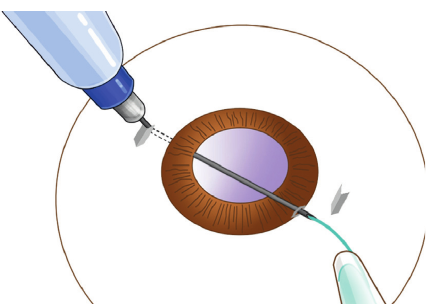
Figure 2: Diagram of the leading haptic guided by the needle.